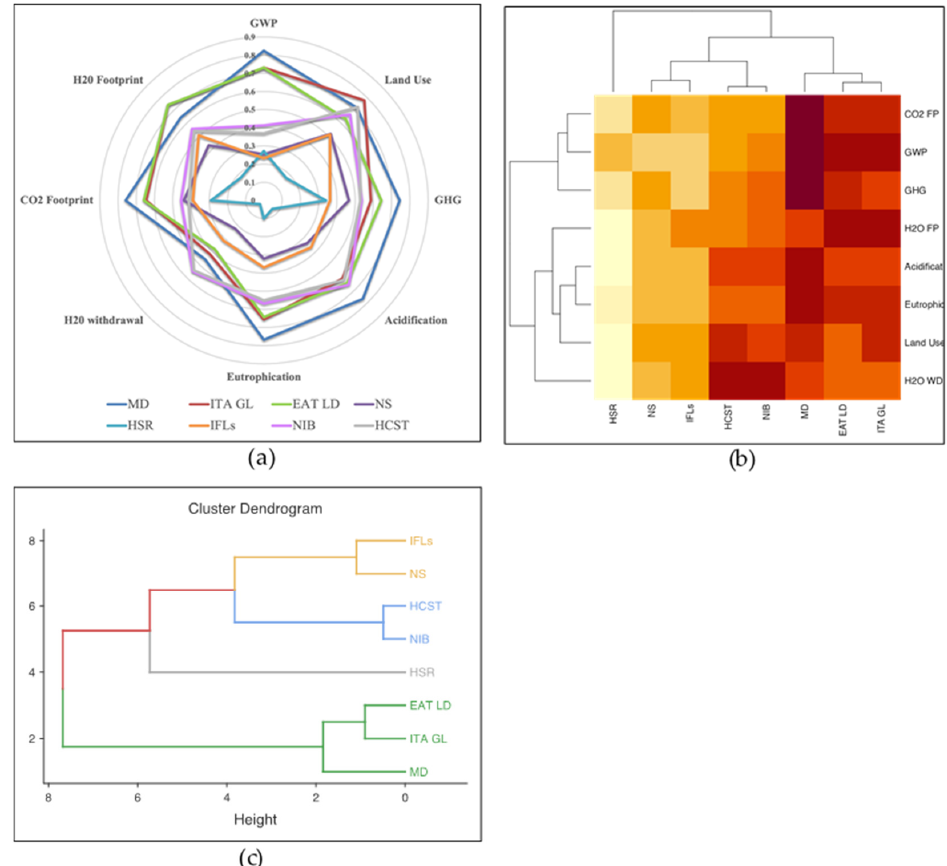
Figure 2. ( a ) Radar chart of Spearman’s correlations between FOPLs, healthy and sustainable diets, and indicators of environmental sustainability; ( b ) heatmap of cluster analysis between FOPLs, healthy and sustainable diets, and indicators of environmental sustainability; ( c ) dendrogram on FOPLs and healthy and sustainable diets. Abbreviations: MD= Mediterranean Diet; ITA GL = Italian Dietary Guidelines; EAT LD= EAT Lancet Diet; NS= Nutriscore; HSR = Health Star Ratings; IFLs= Israeli Food labels; NIB= NutrInform Battery; HCST = Health Canada Surveillance Tool; CO2 FP= CO 2 Footprint; GWP= Global Warming Potential; GHG= Greenhouse Gas ; H2O FP= H 2 O Footprint; H2O WD= H 2 O withdrawal.